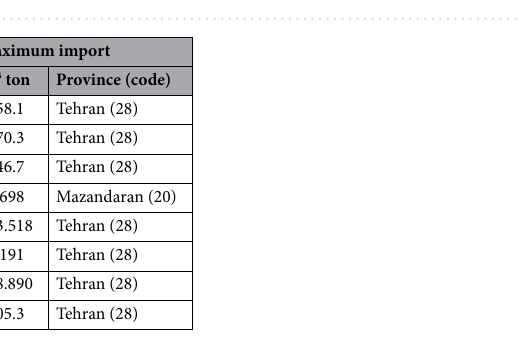
Figure 4. Spatial visualization of net crop trade by province: Positive sign denotes imports; negative sign denotes exports (ArcGIS 10.3.1).